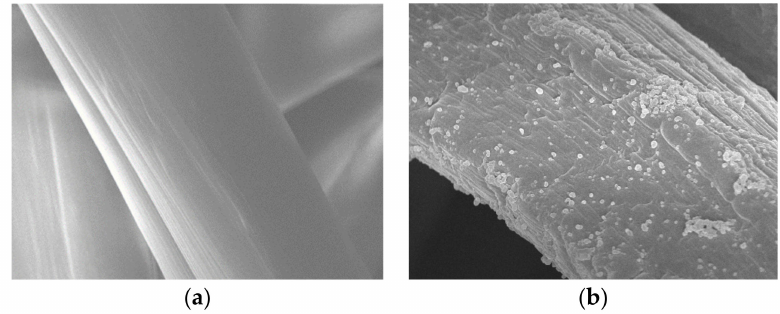
Figure 10. SEM micrographs ( × 5000) of ( a ) untreated chitosan nonwoven and ( b ) trypsin-immobilized chitosan